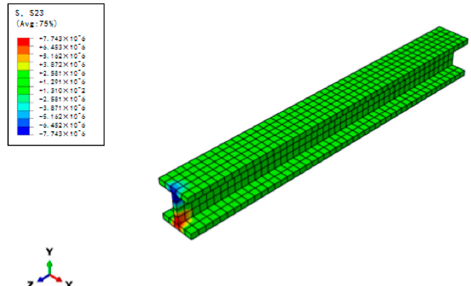
Figure 15. The stress nephograms of section steel in the direction of S23.